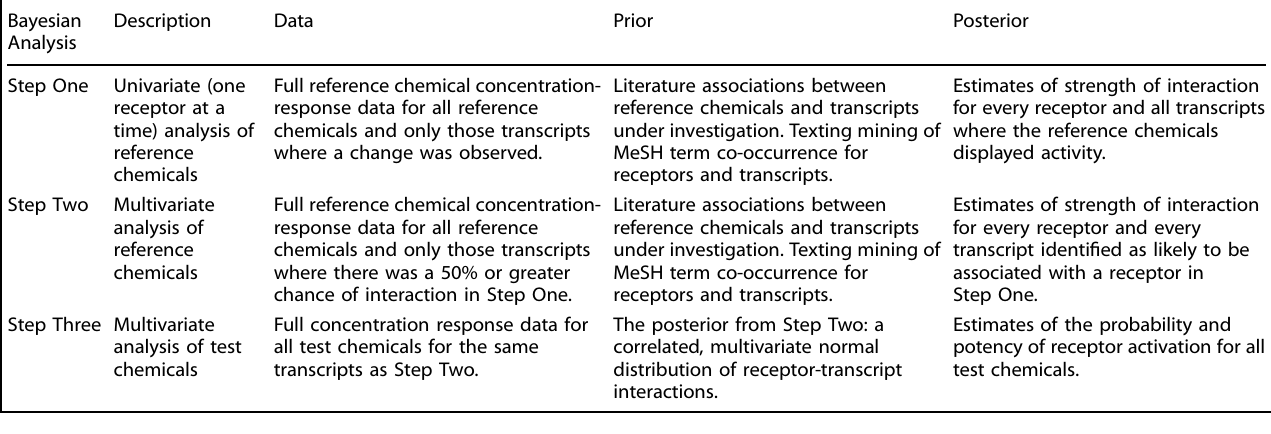
Table 1. A Bayesian analysis combines prior information with new data to generate a posterior distribution re fl ecting the likely outcomes based on both the prior and the new data.